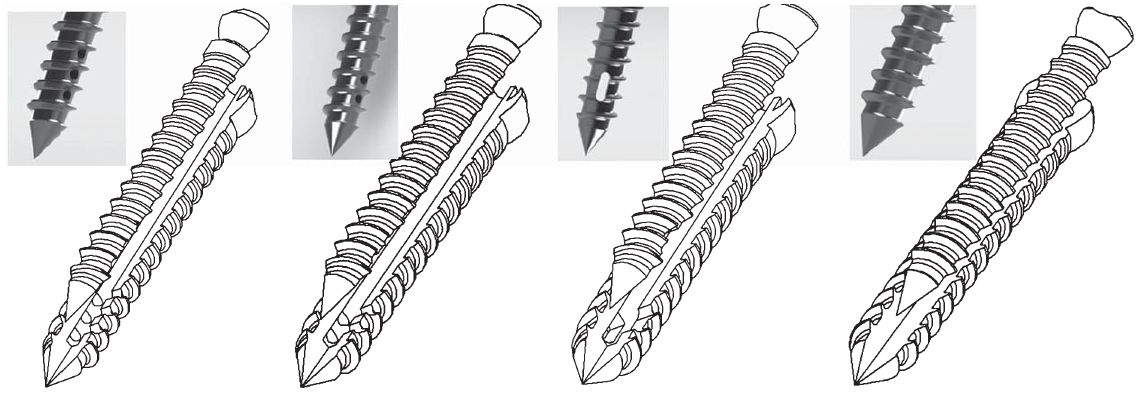
Fig. 2. Cross section and illustration of hole/gap types. Three holes, two holes and slot including designs with solid cored screw design. (From left to right).